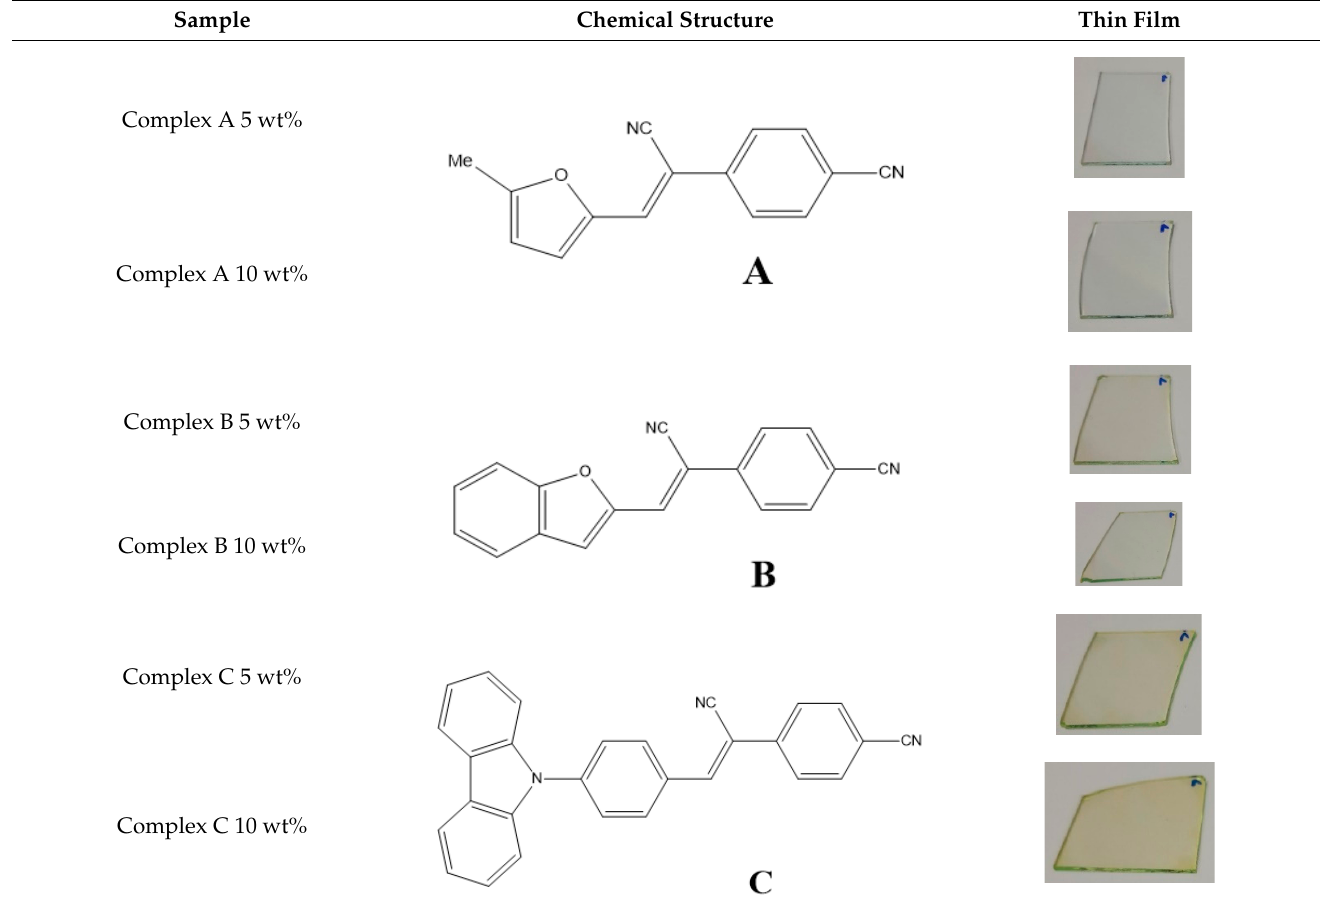
Table 1. Description of experimentally investigated samples.